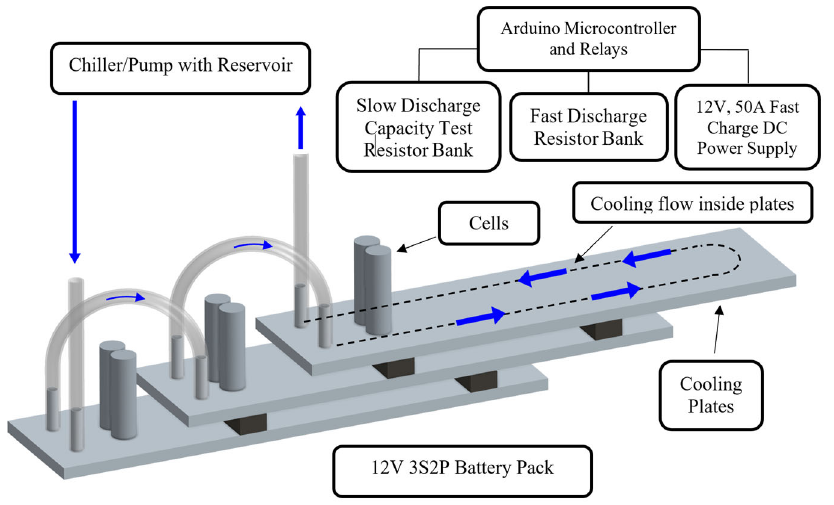
Figure 1. Test system layout: Pack of six cells (three pairs in series) with a thermal management system consisting of three cooling plates.